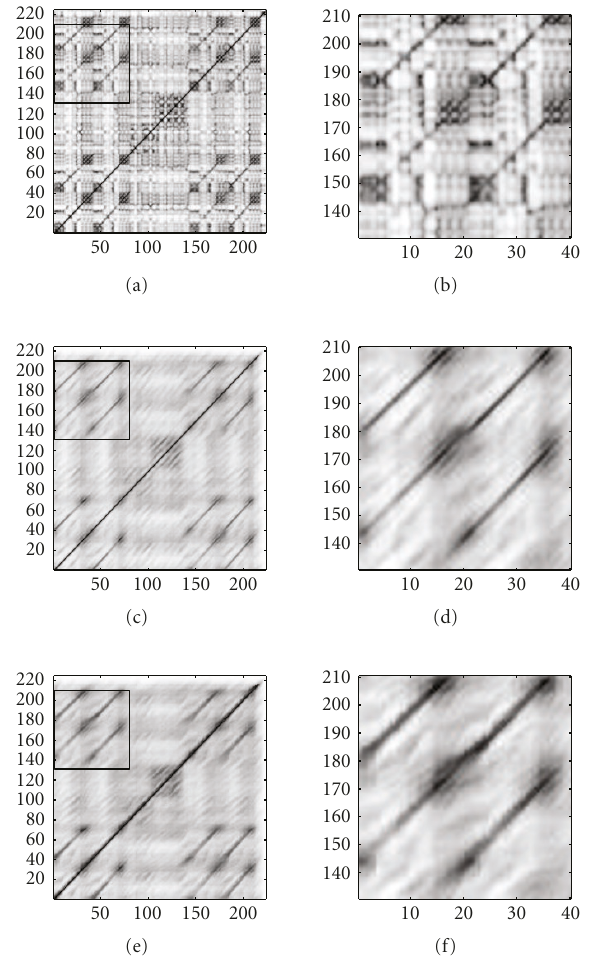
Figure 6: Enhancement of the similarity matrix of the Shostakovich example; see Figure 2. (a) and (b): S [41,10] and enlargement. (c) and (d): S 10 [41,10] and enlargement. (e) and (f): S min 10 [41,10] and enlargement.